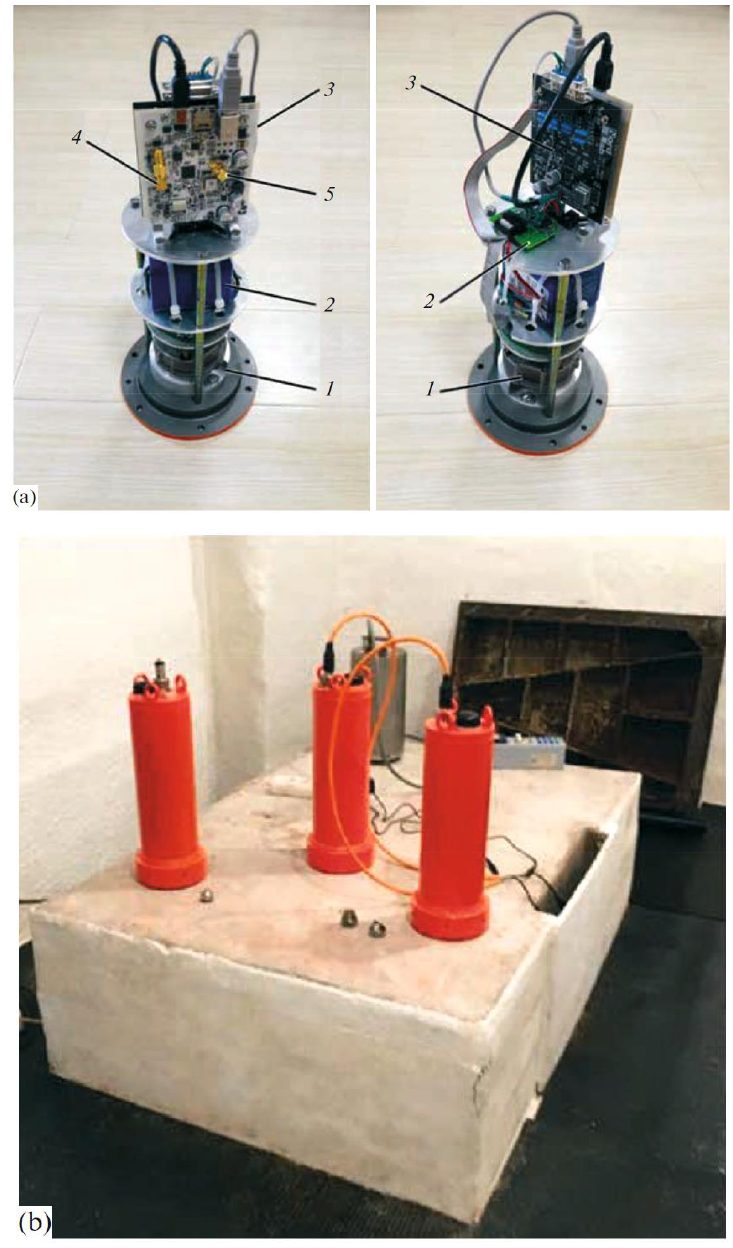
Figure 1. Design of geohydroacoustic module ( a ) and external view of buoy placed on pedestal in Obninsk, 30 August 2017 ( b ). (1) Analog molecular–electronic vertical seismic sensor; (2) lithium ion battery with interface board; (3) 24-bit seismic data acquisition system; (4) USB / WiFi antenna connector; (5) external GPS antenna